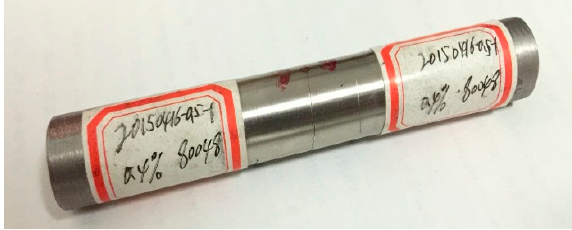
Figure 6. Typical failure of thinned tube.